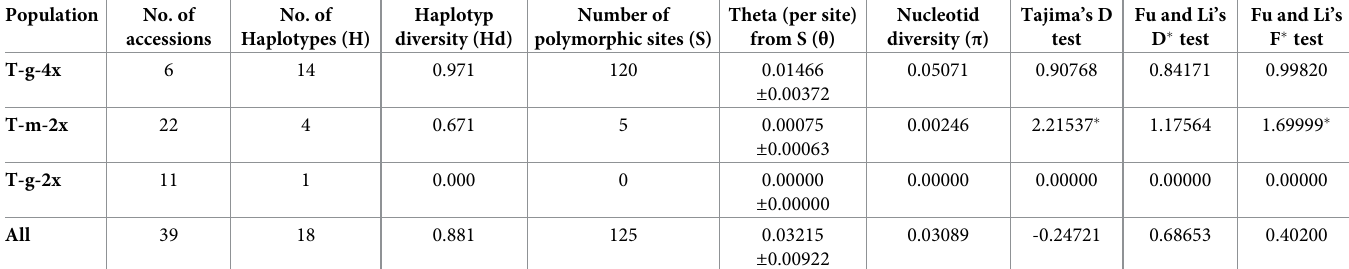
Table 2. Estimates of nucleotide diversity per base pair and test statistics for selection at TRX gene in different barley populations. The three populations are T-g-4x ( H . marinum subsp. g ussoneanum4x ), T-m-2x ( H . marinum subsp. marinum 2x) and T-g-2x ( H . marinum subsp. g ussoneanum 2x) respectively. Note: the gaps/missing/ data were excluded; � significant at 0.05 level.